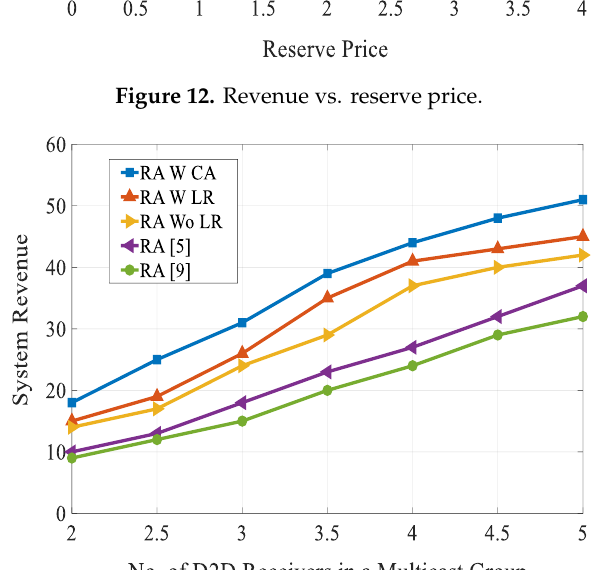
Figure 13. System revenue vs. no. of D2D receivers in a multicast group.